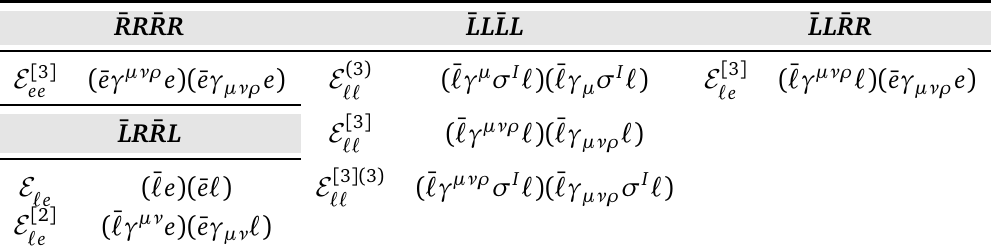
Table 7: Leptonic four-fermion evanescent operators. We use the shorthand